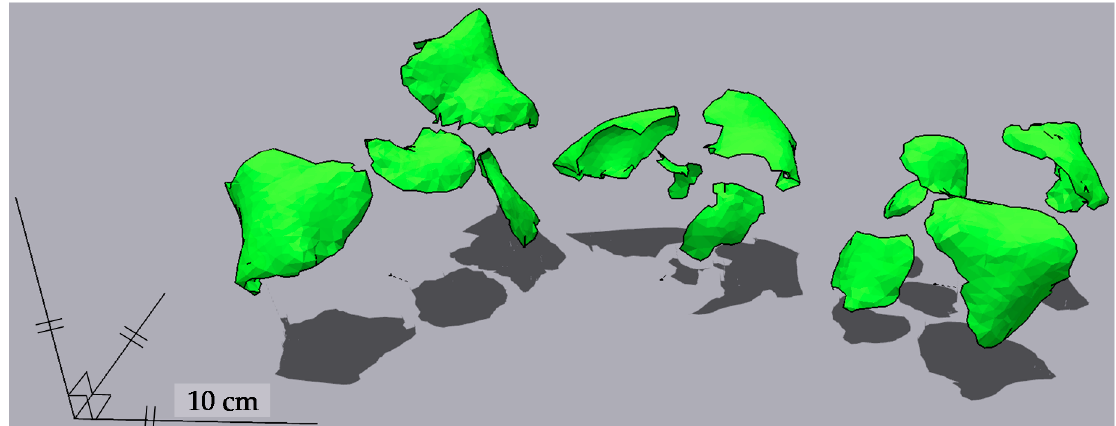
Figure 1. 3D models of the canola seedlings. These models are made by converting point cloud data to the polygonal model using an OPT cloud survey (OPT Technologies Co., Ltd., Tokyo, Japan) and by reducing the number of triangle polygons to 1% using Houdini (Side Effects Software Inc., ON,